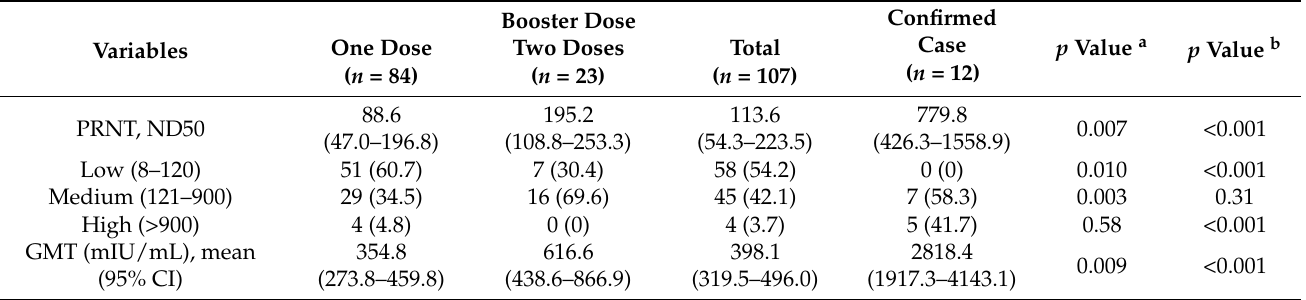
Table 2. Comparison of two-year immune response and immune durability of each group after one or two booster doses of MMR vaccine or laboratory-confirmed measles infection among young, seronegative healthcare workers.